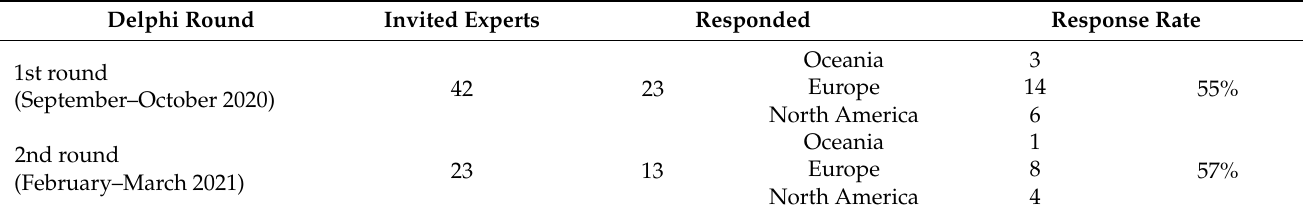
Table 4. Structure of the Delphi survey respondents.